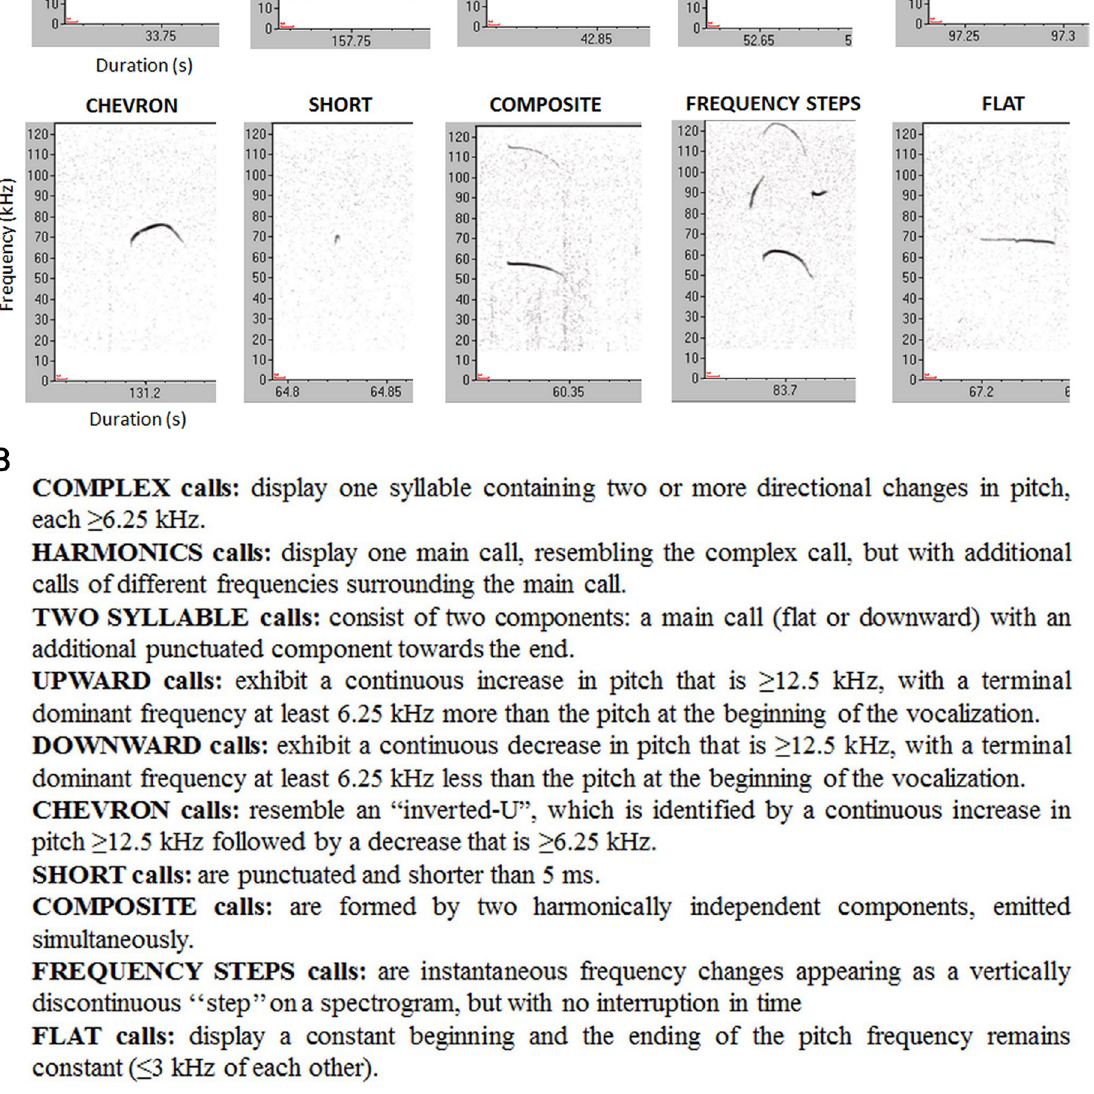
Fig 1. Examples of USVs categories emitted by mice. (A) Representation of typical spectrograms of different USVs categories. (B) Description of the features of the 10 USVs types. • So called “ Standard features ”, that are 20 features obtained by the Avisoft software orga- nized in a 20-dimensional vector. They are: duration, peak to peak, quart 50 (start), quart 75 (start), peak frequency (start), peak amplitude (start), peak frequency (end), peak amplitude